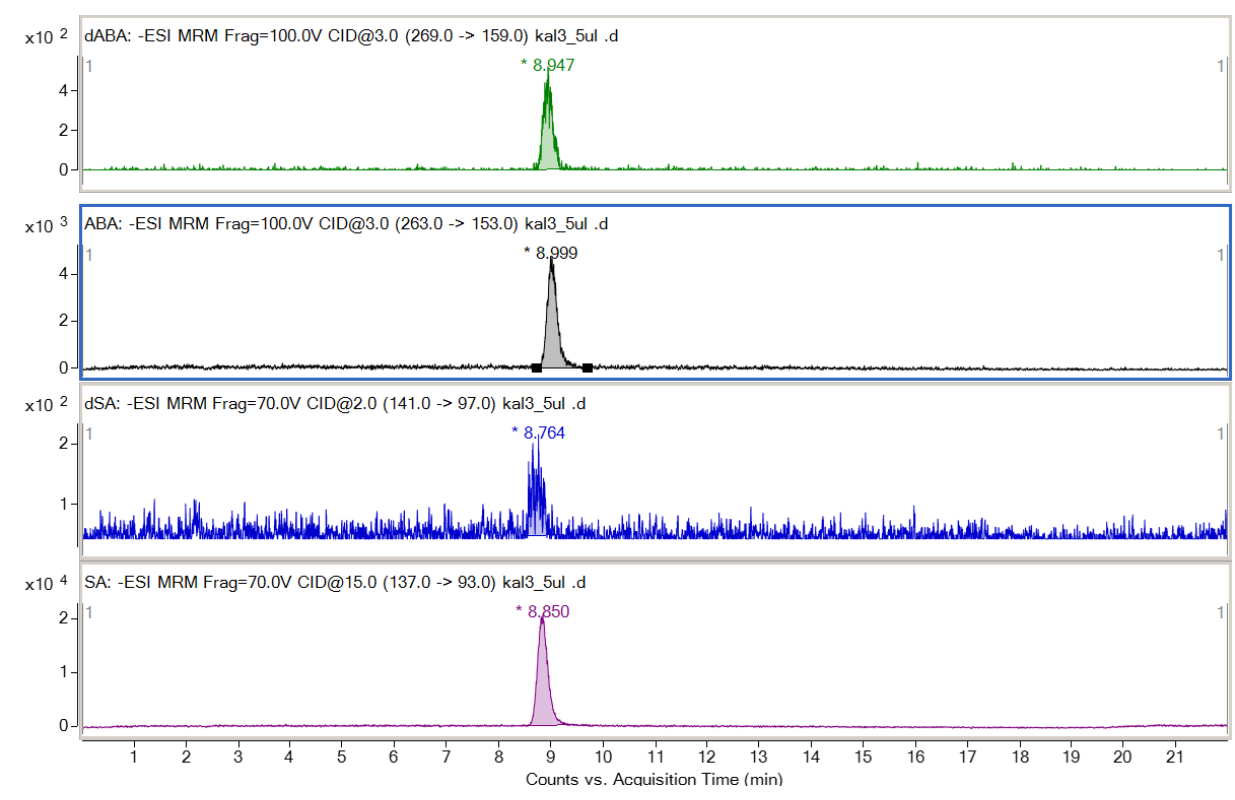
Figure 2. MRM chromatograms of calibrant 3 with ABA (black) and SA (purple) concentrations of 480 ng mL −1 spiked with isotopic labeled standards ABA-d 6 (green) and SA-d 6 (blue).